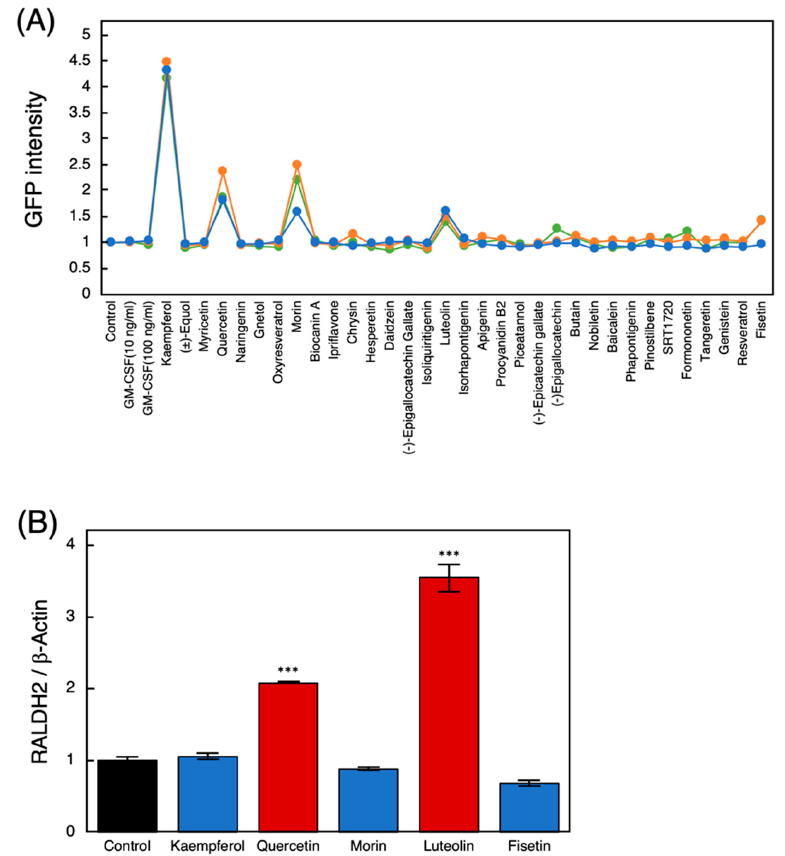
Figure 1. Screening for polyphenols that activate the Raldh2 promoter in THP-1 cells. ( A ) THP-1 (Raldh2p-GFP) cells differentiated using phorbol 12-myristate 13-acetate were treated with 33 polyphenols (10 µ M) and incubated for 24 h. Changes in EGFP fluorescence were monitored using IN Cell Analyzer 2200 (green, orange and blue show three independent experiments). ( B ) The effect of quercetin and luteolin on the expression of endogenous RALDH2 mRNA in differentiated THP-1 cells was assessed via quantitative reverse transcription-polymerase chain reaction. Dimethyl sulfoxide (DMSO) was used as a control. Two-sided Student’s t -test was used to test for significant differences compared to the results of the controls. Significance was defined as *** p < 0.001. Raldh2: retinaldehyde dehydrogenase 2; EGFP: enhanced green fluorescent